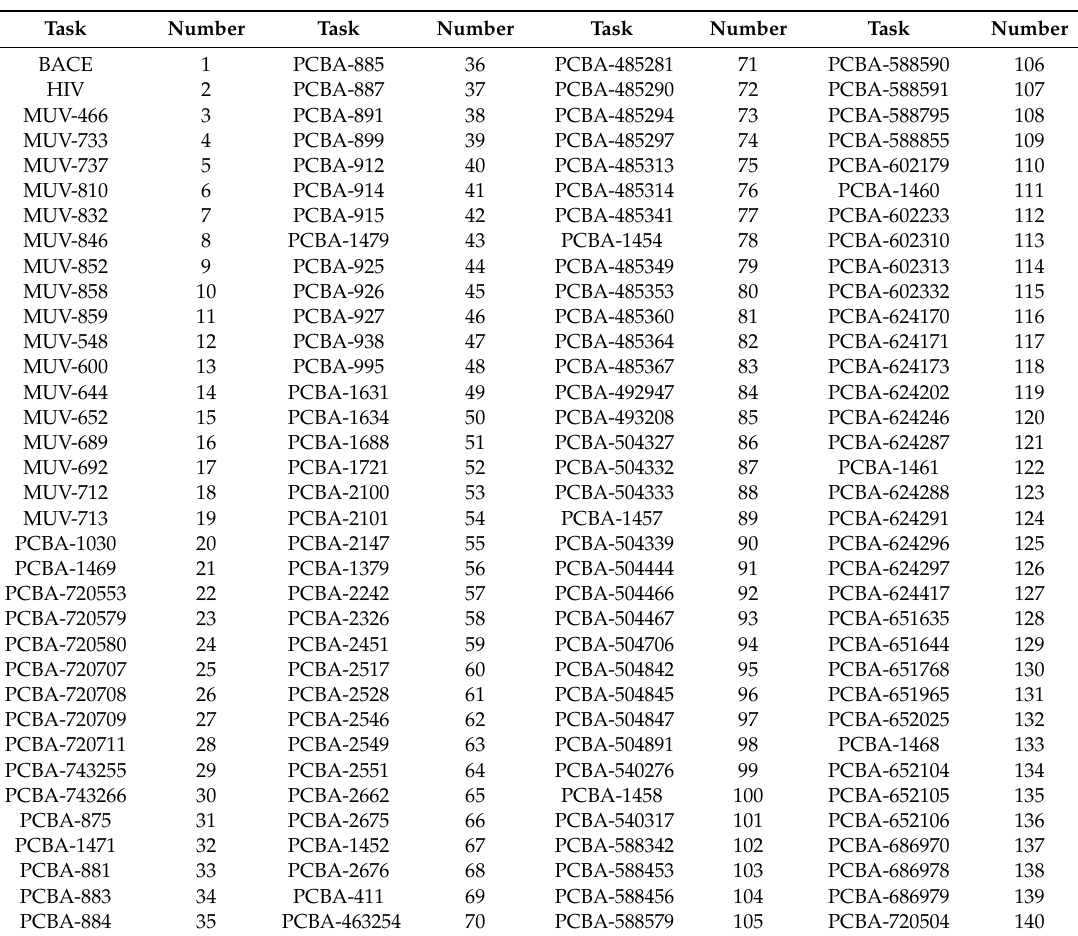
Table A2. Source tasks and their referred number within the figures, part